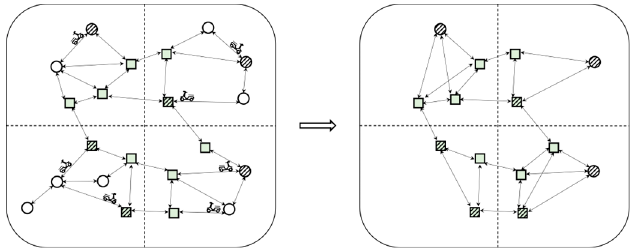
Figure 6. The comparison between the vertex subgraph and original road network graph.